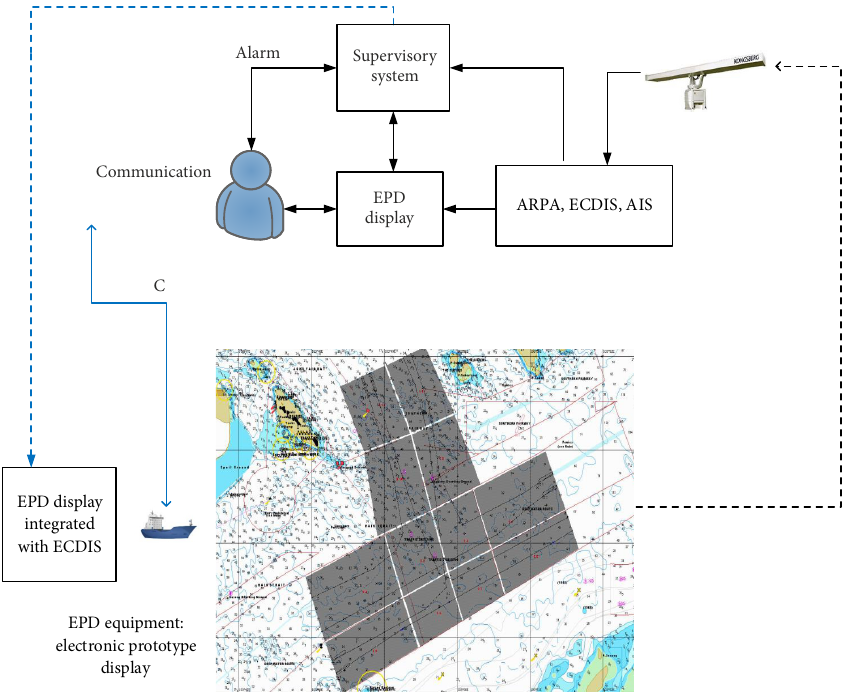
Figure 2. Proposal for the vessel traffic management